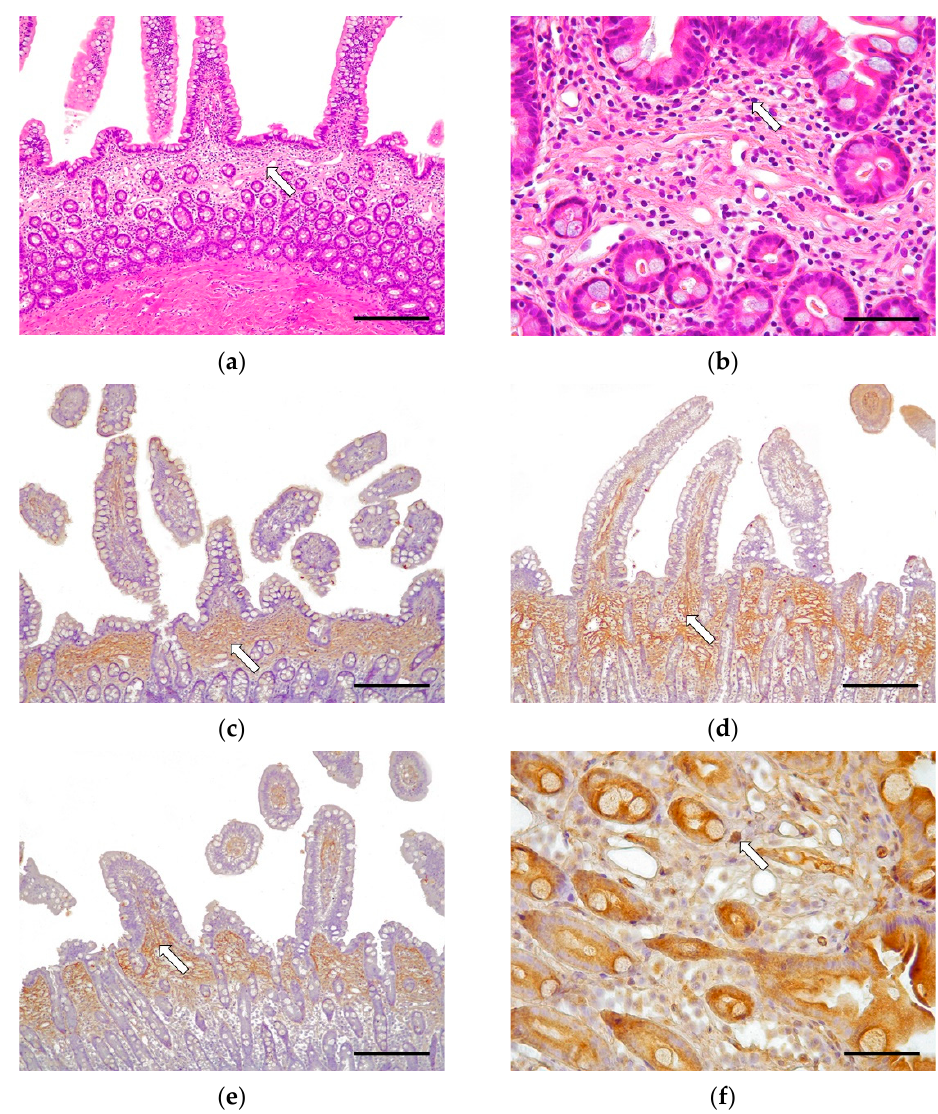
Figure 1. Chronic eosinophilic enteritis (Grade I). Cat, duodenum, case No. 4. ( a ) There is mild fibrosis that displaces down the glandular crypts (arrow). Hematoxylin–eosin. Scale bar: 1000 µ m. ( b ) Surrounding the fibrotic areas, there is a moderate inflammatory infiltrate composed by lympho- cytes, plasma cells, and eosinophils (arrow). Hematoxylin–eosin. Scale bar: 100 µ m. ( c ) Moderate fibrillar immunoexpression for collagen I in the lamina propria, in the base of the villi, and above the crypts (arrow). Rabbit polyclonal anti-collagen I. Scale bar: 1000 µ m. ( d ) Intense diffuse and reticullar collagen III immunoexpression in the connective tissue of the lamina propria (arrow). Rabbit polyclonal anti-collagen III. Scale bar: 1000 µ m. ( e ) Moderate reticular fibronectin immunoexpres- sion at the base of the villi in the lamina propria (arrow). Rabbit polyclonal anti-fibronectin. Scale bar: 1000 µ m. ( f ) Moderate cytoplasmic TGF- β 1 immunoexpression in epithelial cells of the crypts, mononuclear cells (arrow), and, to a lesser extent, in the lamina propria around fibroblasts. Rabbit polyclonal anti-TGF- β 1. Scale bar: 100 µ